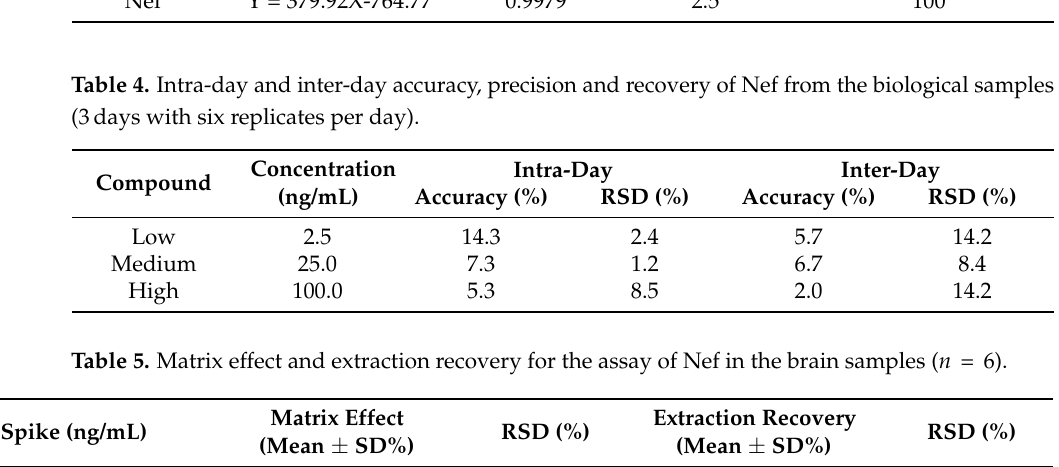
Figure 7. Representative chromatograms of Nef and IS in mouse brain homogenate. ( A ) blank mouse brain sample; ( B ) LLOQ brain sample; ( C ) mouse brain samples collected after the tail vein intravenous administration of Nef. IS: Resveratrol (Resv). Table 3. Regression analysis and limit of detection (LOD) of the proposed UPLC-MS/MS method. Regression Equation Correlation Detection Limit Compound Coefficient